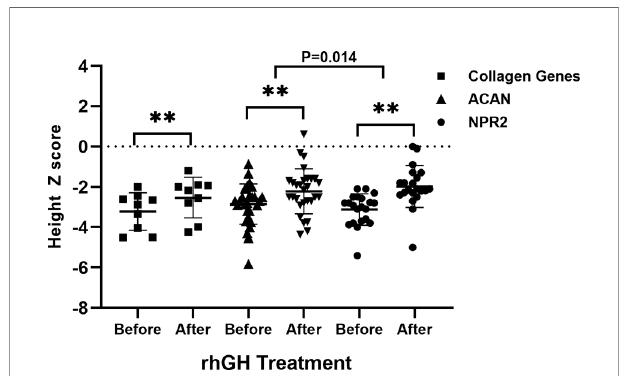
FIGURE 4 | Comparison of growth response to rhGH between patients with collagen gene, ACAN , and NPR2 mutations. **p